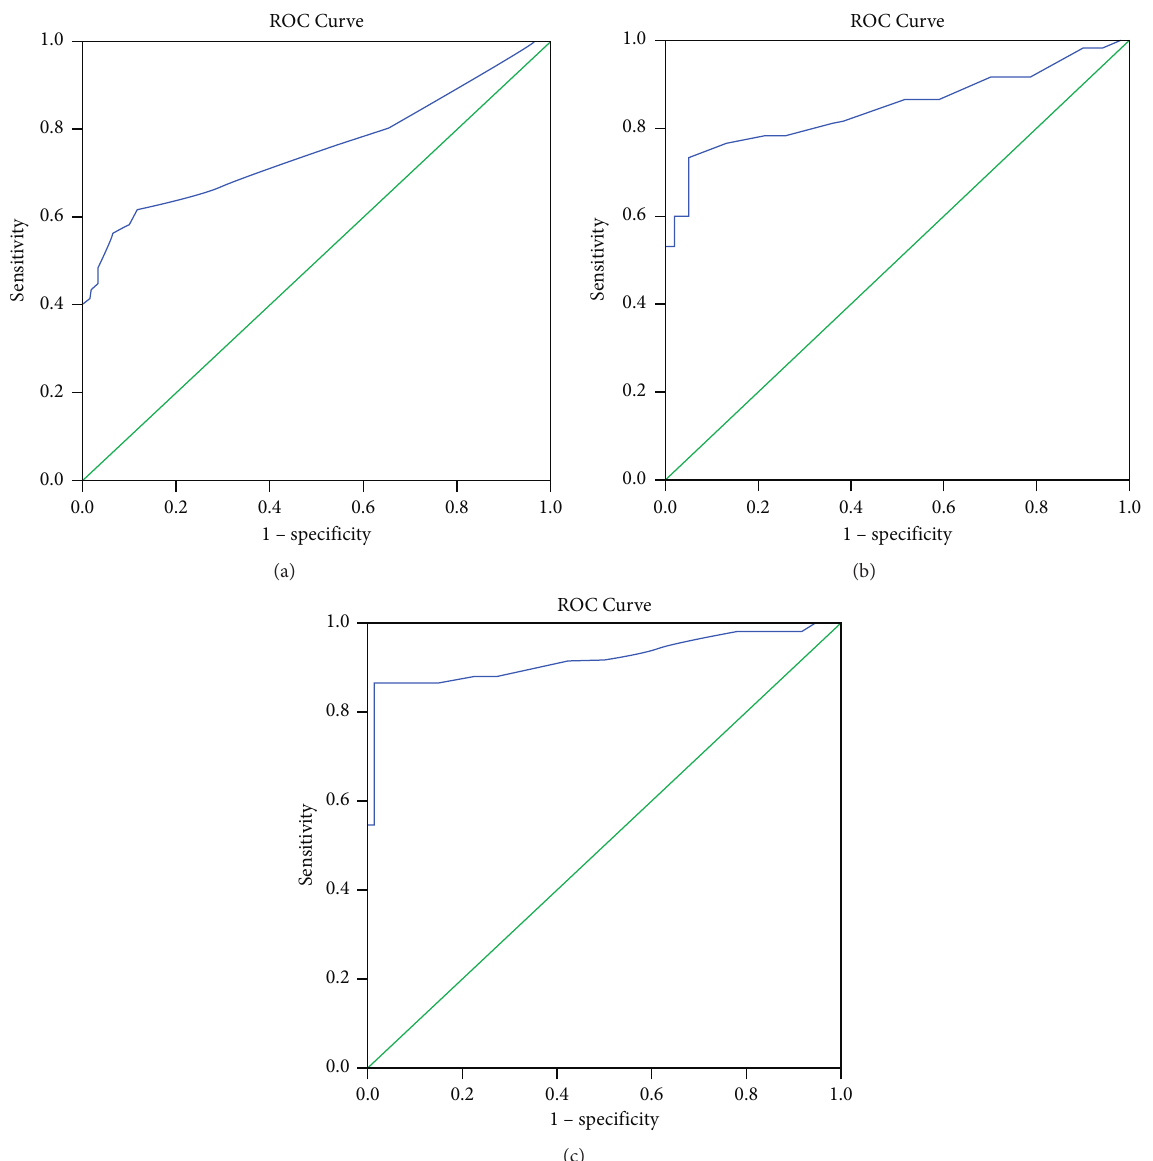
Figure 2: Receiver operating characteristic ROC curve analysis for (a) RF, (b) anti-CCP, and (c) 14-3-3 η . Table 4: Agreement (sensitivity and specificity) for serum RF, ACCP, and 14-3-3 η to predict early RA patients (vs. control). 95% CI AUC p Cutoff Sensitivity Specificity PPV NPV LL UL